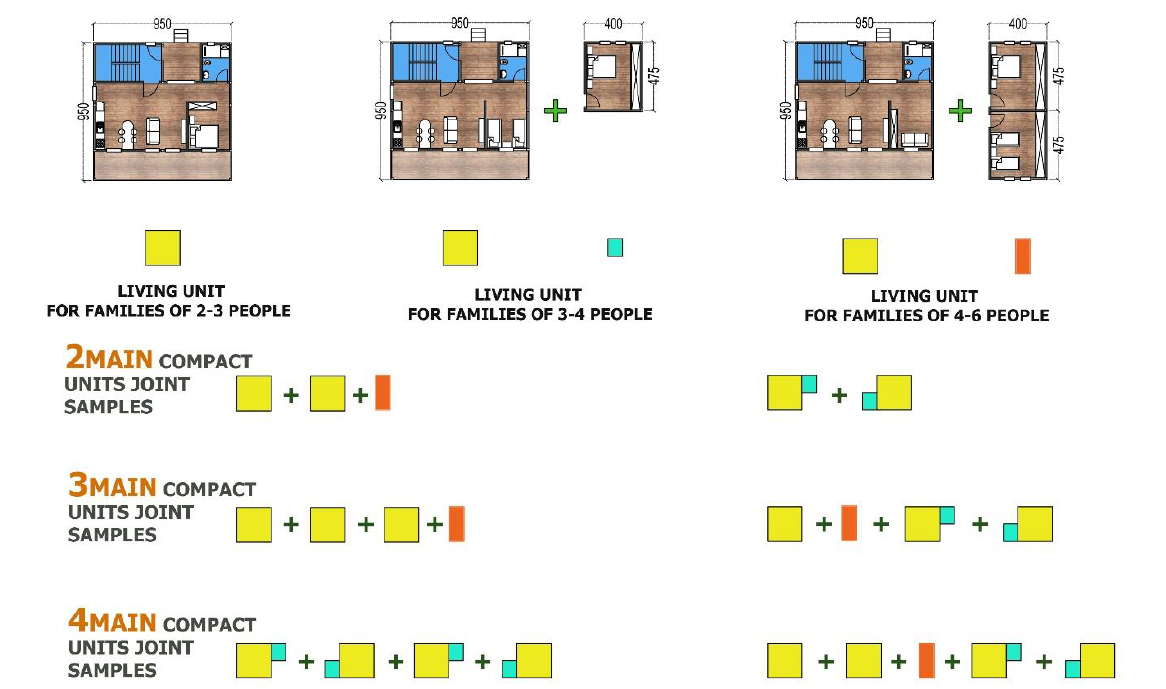
Figure 6. Ecological living units’ flexible space organization